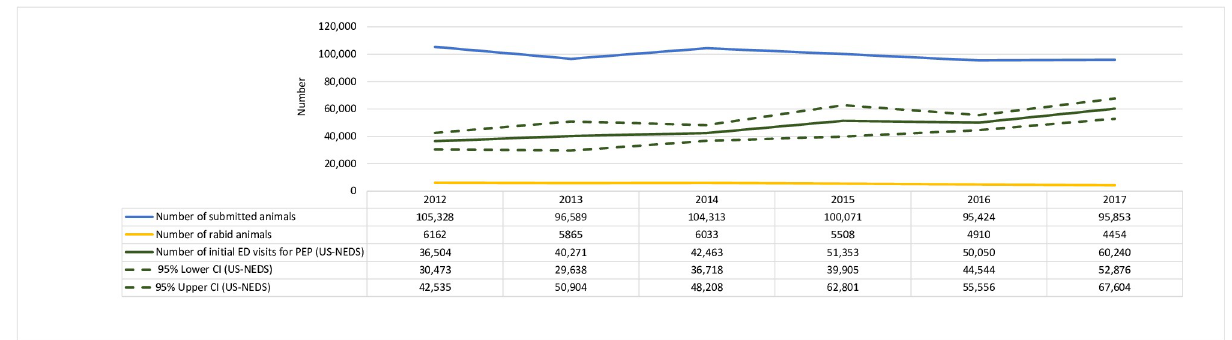
Fig 2. Trends in the national-level estimate of PEP administration and submitted animals for rabies –2012–2017. The number of initial visits for rabies postexposure prophylaxis using the Nationwide Emergency Department Sample (NEDS) with 95% confidence intervals [CI] (green solid & dashed lines), animals submitted for rabies testing to the Centers for Disease Control and Prevention (blue line), and rabies-positive animals submitted to the Centers for Disease Control and Prevention (yellow line) during